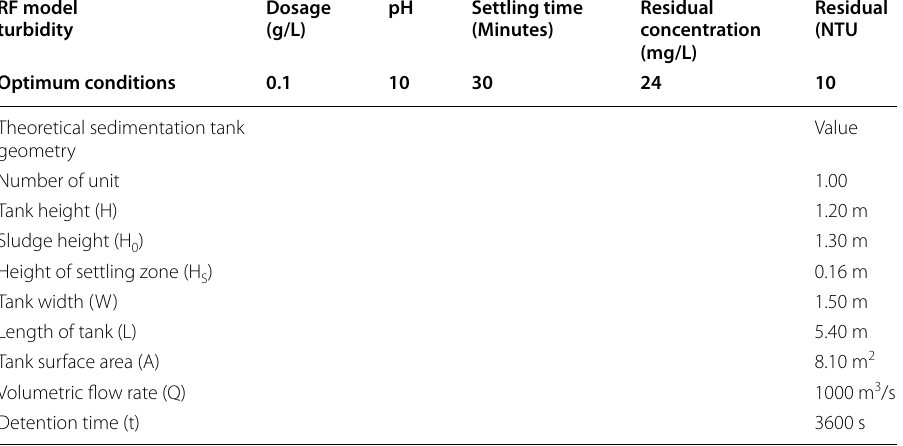
Table 5 Machine learning optimized sedimentation tank dimensions RF model turbidity